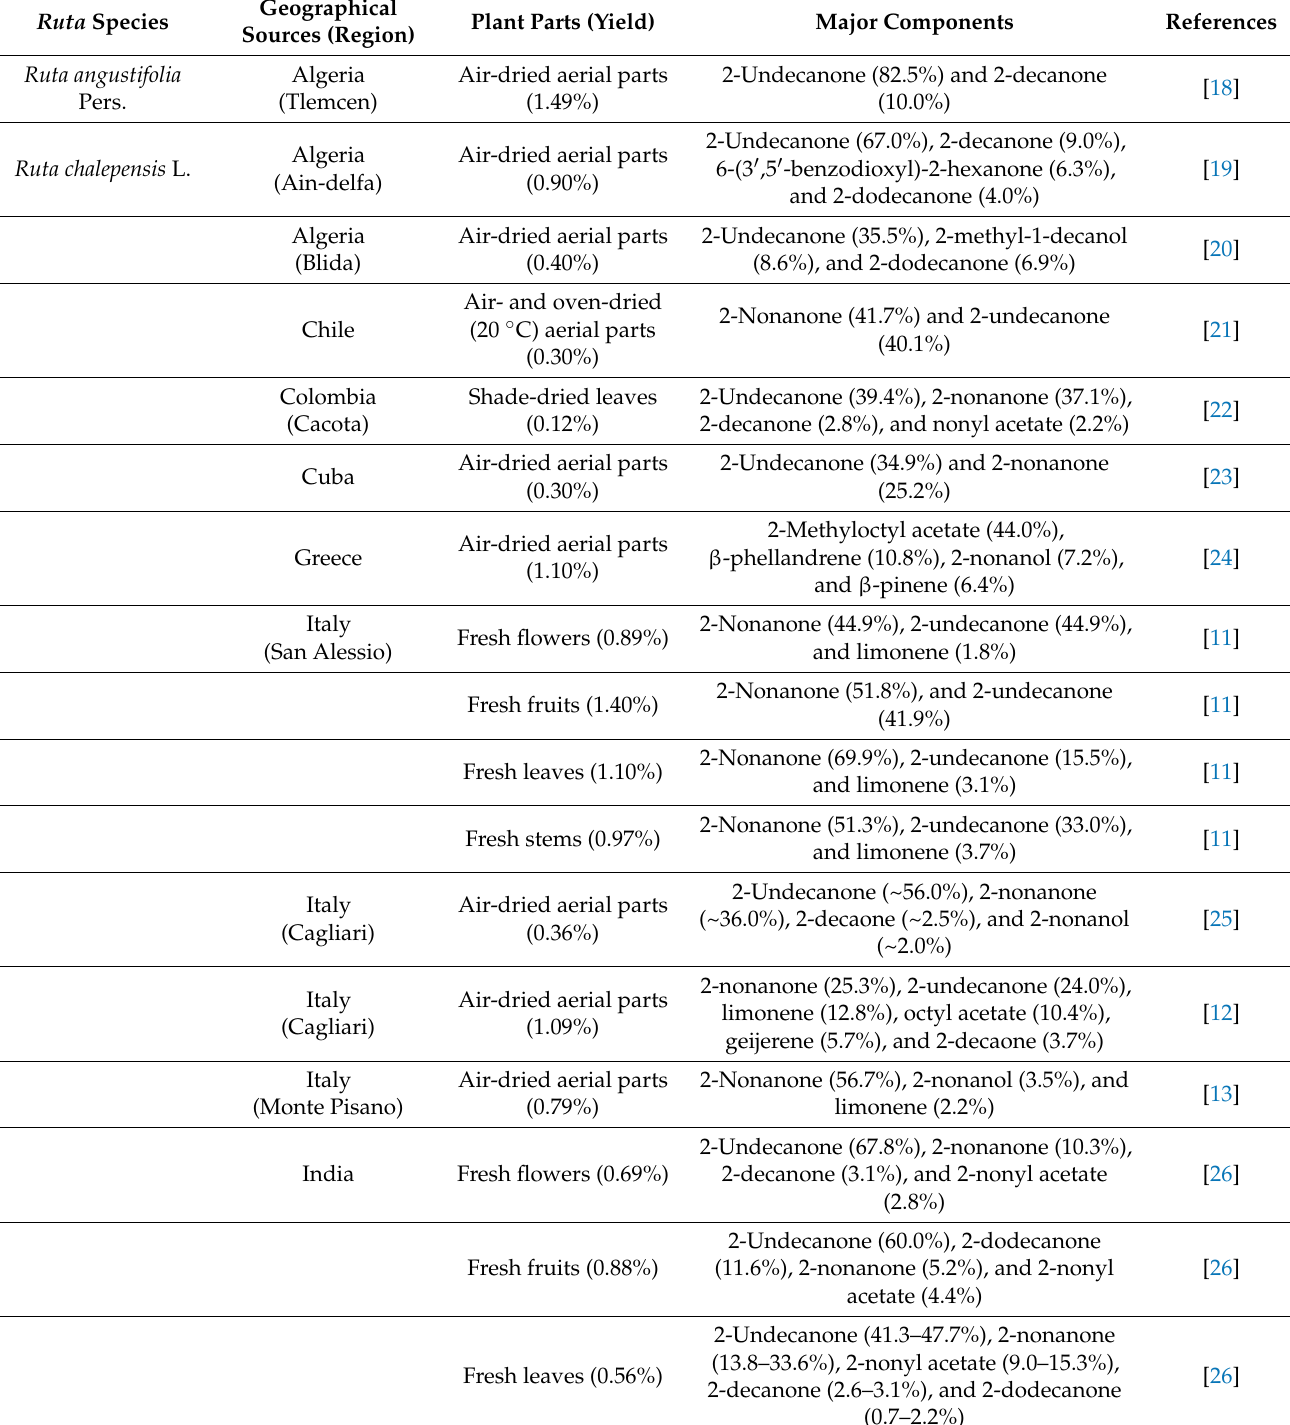
Table 1. Major components of the essential oils of Ruta species from different geographical origins. Geographical Ruta Species Plant Parts (Yield) Major Components Sources (Region)